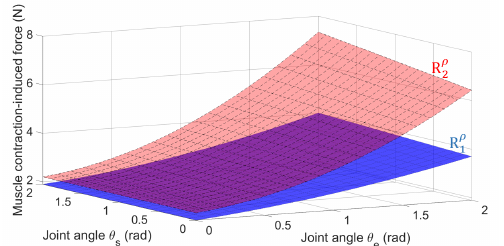
Figure 5: Illustration of payload estimation when two payloads are used for training the regression models.